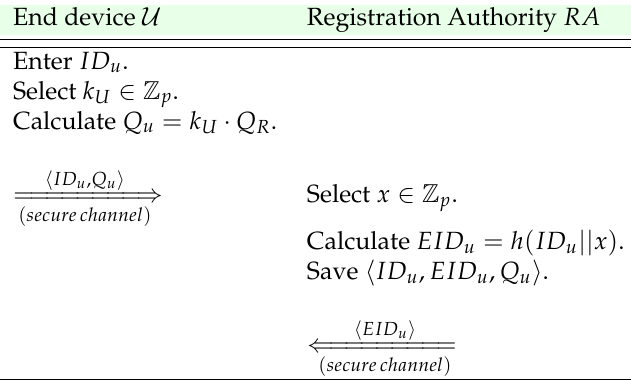
Figure 2. Summary of end device